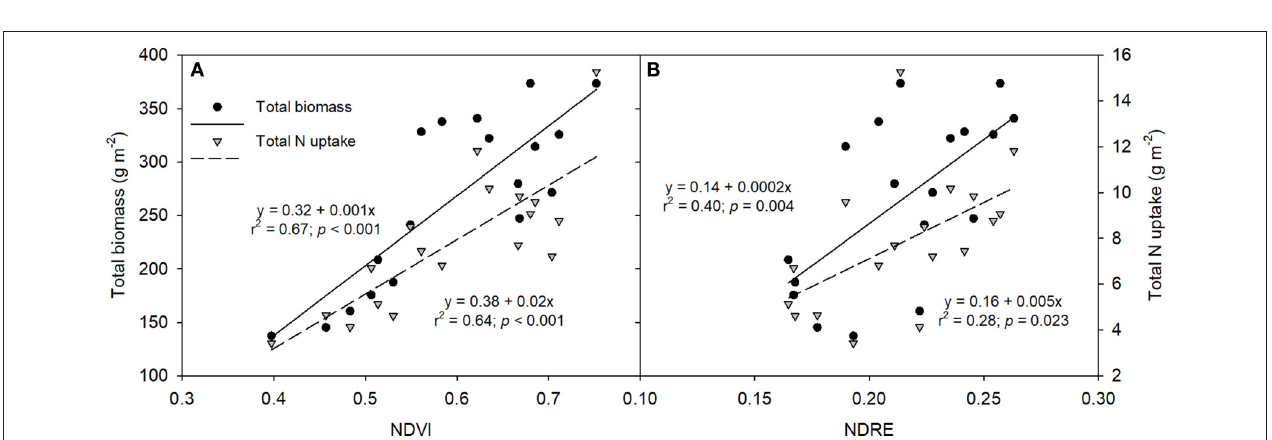
FIGURE 4 | Normalized Difference Vegetation Index (NDVI) (A,B) and Normalized Difference Red Edge (NDRE) (C,D) of corn at growth stage V6 and R1 during the 2017 corn growing season.